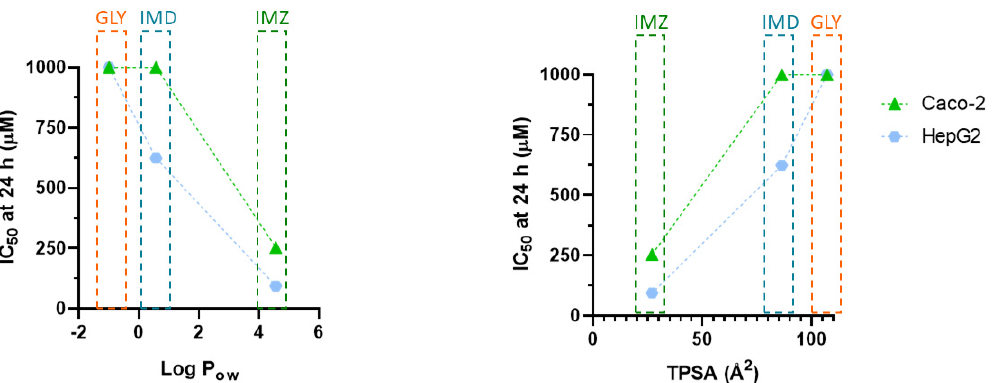
Figure 7. Correlation between pesticides-induced toxicity, represented by IC 50 values, and pesticide Log P ow (left panel) or with pesticide TPSA (right panel). The IC 50 values were obtained from in vitro cytotoxicity assays (see Table 1) in cells subjected for 24 h to different concentrations of respective pesticide (see methods for details). Caco-2 and HepG2 IC 50 values are denoted by green triangles and blue circles, respectively.